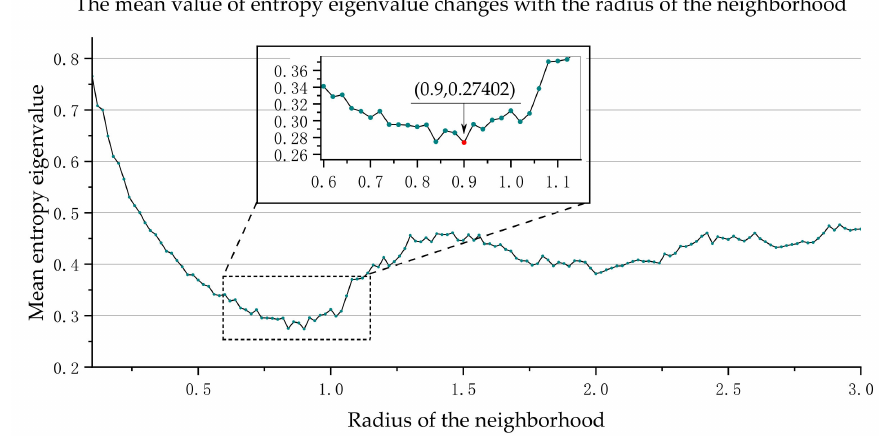
Figure 8. The mean entropy eigenvalue of 50 m OCS point cloud changes with the radius of the neighborhood.